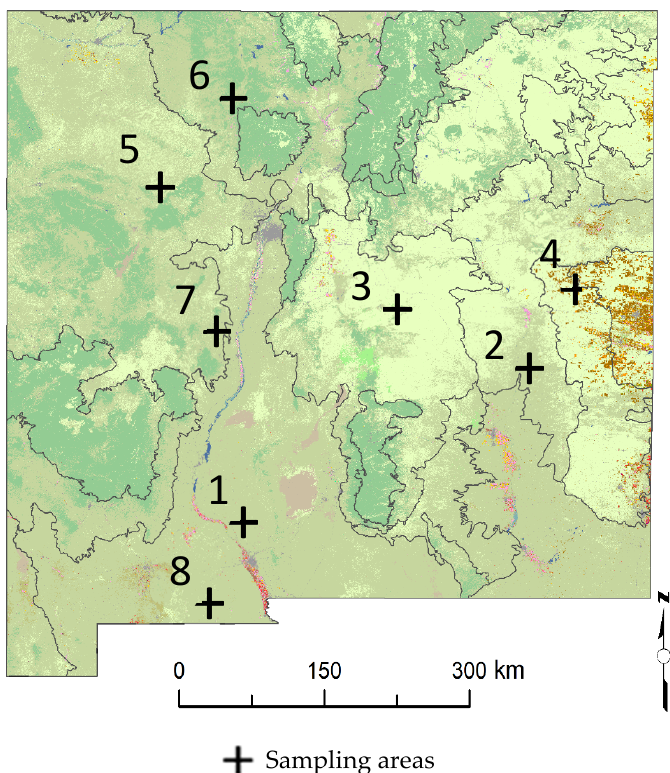
Figure 2. Sampled fields from different Major Land Resources Areas (MLRA) and areas in New Mexico included Southern Desert Basins, Plains, and Mountains (MLRA 42) (Area 1), Southern High Plains, Southern Part (MLRA 77C) (Area 2), Central New Mexico Highlands (MLRA 70C) (Area 3), Upper Pecos River Valley (MLRA 70B) (Area 4), Colorado Plateau (MLRA 35) (Area 5), Southwestern Plateaus, Mesas, and Foothill (MLRA 36) (Area 6) [19], Los Lunas Agriculture Science Centers, Los Lunas (Area 7), and Leyendecker Plant Science Center (Area 8).